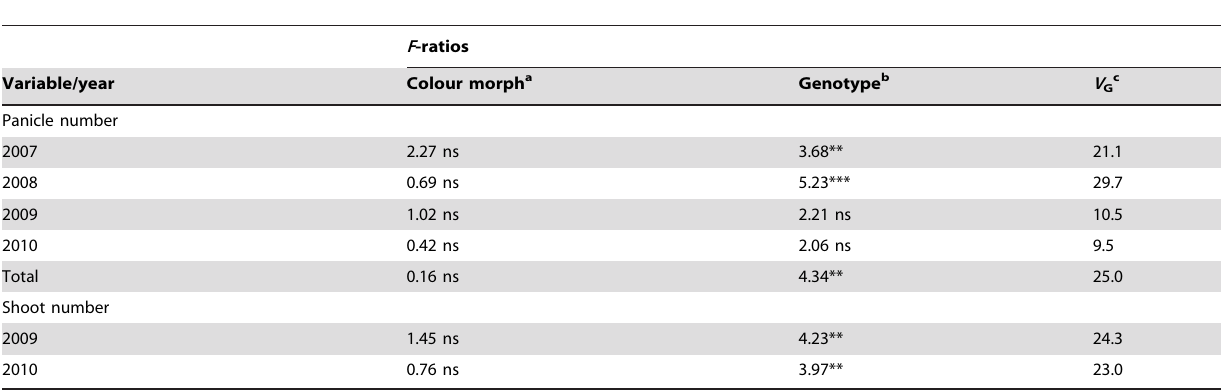
Table 2. Results from ANOVAs ( F -ratios) and variance component analyses for traits measured on S. album plants paired with a genetically identical